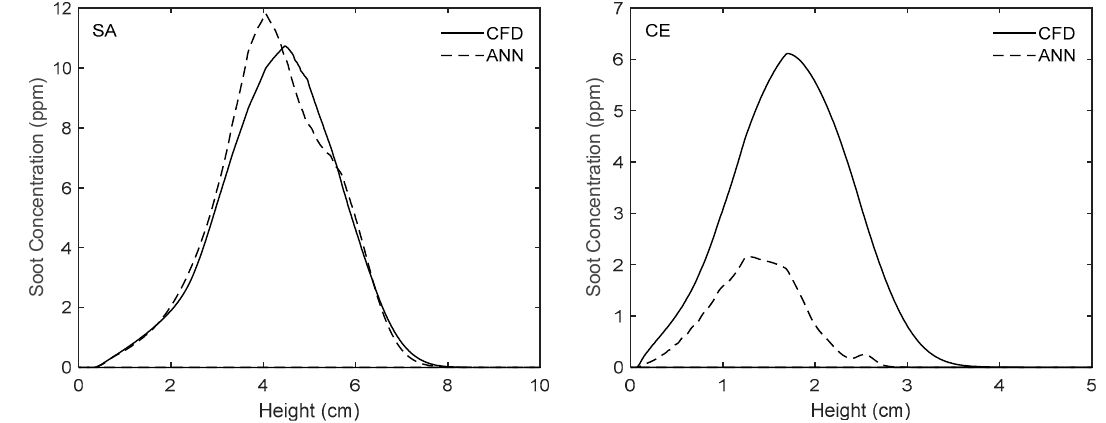
Figure 15. Comparison of experimentally-validated CFD results and those obtained from the ANN along the streamline of maximum soot for the flames used to test the network.